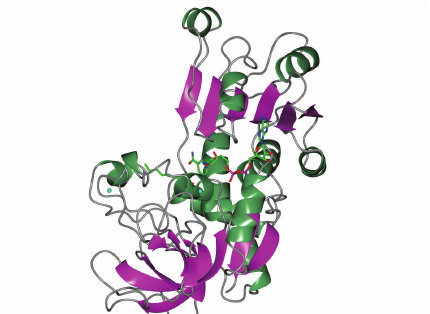
Figure 4: A ribbon diagram of the structure of the Aeropyrum alcohol dehydrogenase enzyme monomer showing the two different domains: the Rossmann domain which binds the NADH cofactor and the substrate-binding domain. The active site is located between thetwodomainswherethecofactorandasubstratemimicarebound and shown as stick models. The two bound zinc ions are shown as blue spheres: the catalytic zinc in the active site and the structural zinc located in a distal loop. The active enzyme has a quaternary structureofatetrameroffouridenticalmonomers(PDBcode1H2B). The Figure was constructed using CCP4mg [53].